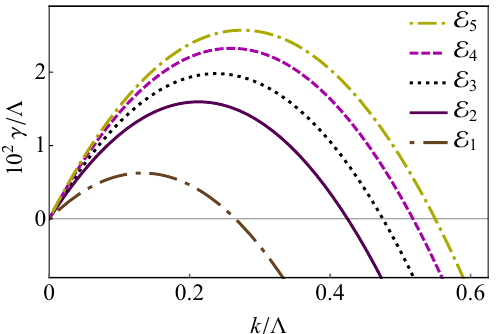
Figure 3 . Growth rates (cid:13) ( k ) given by the (cid:12)rst two terms in (2.14) for the energy densities fE 1 ; E 2 ; E 3 ; E 4 ; E 5 g given in